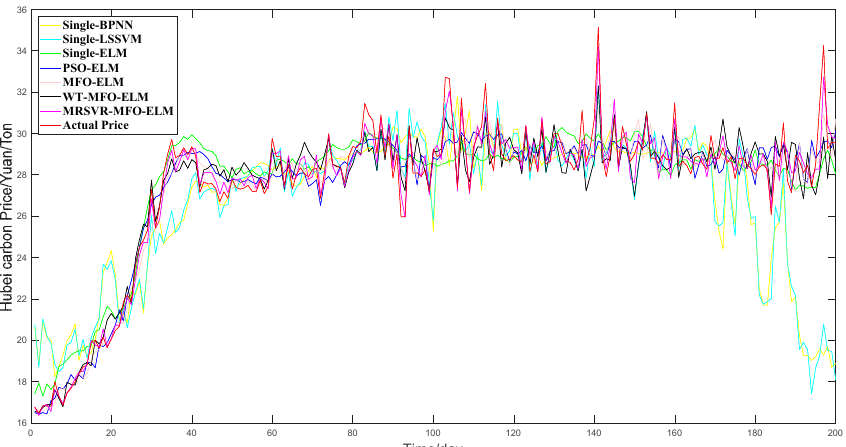
Figure 16. The fitting curves of seven models for Hubei carbon price forecasting.